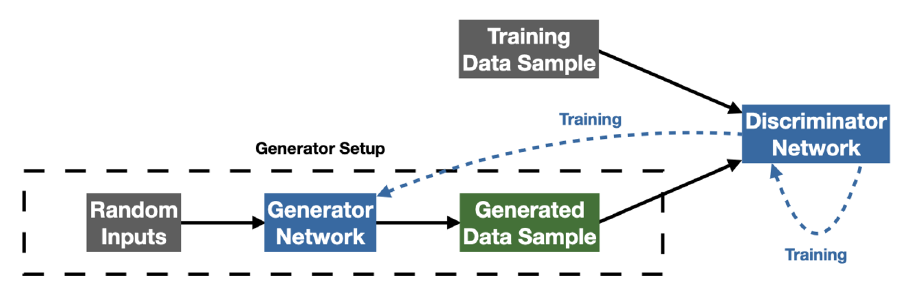
Figure 10 . Schematic representation of a generative adversarial